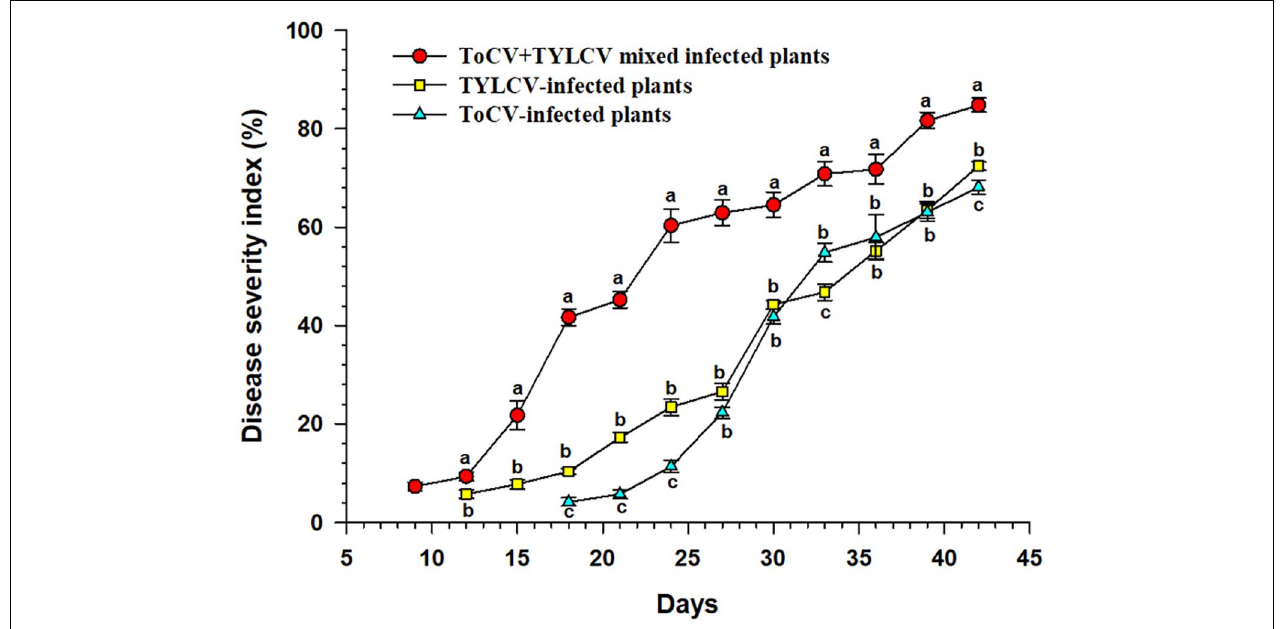
FIGURE 1 | Disease severity index of tomato plants at different times after infection with different viruses. Letters on means at the same day, when different, indicate a significant difference according to one way ANOVA at P < 0.05.